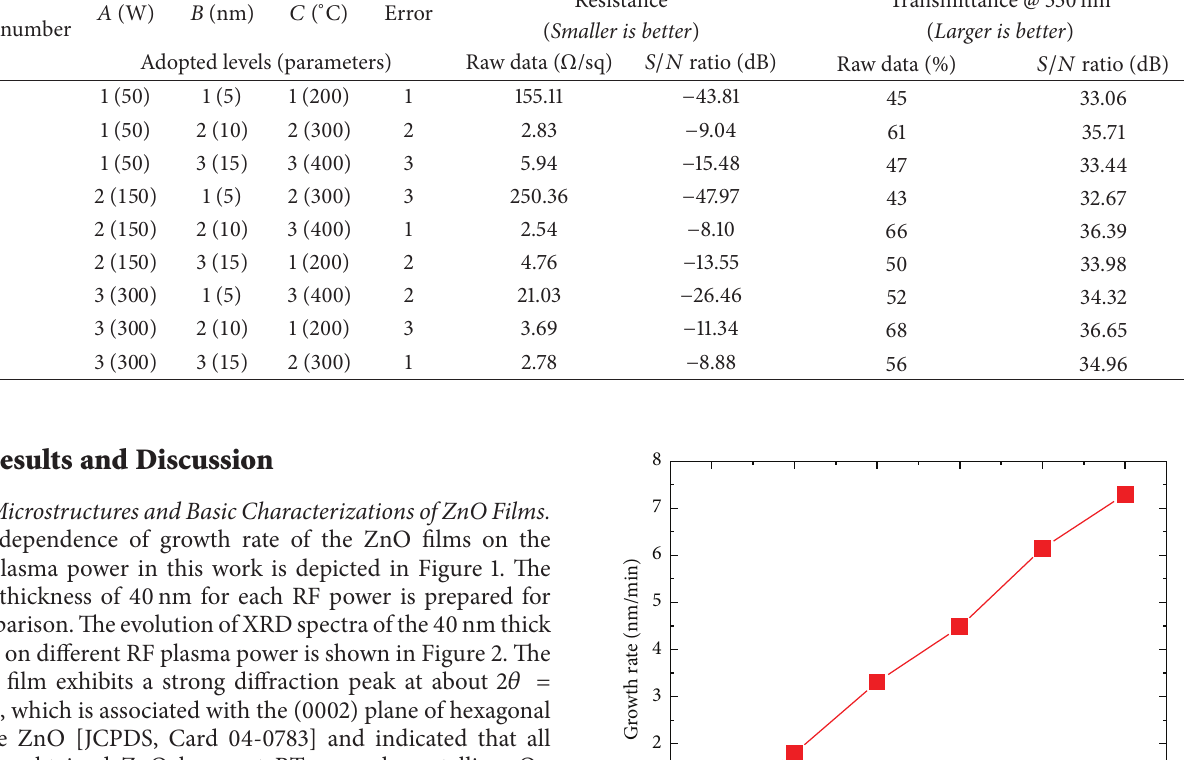
Table 2: Experimental results and 𝑆/𝑁 ratios for the resistance ( Ω /sq) and the transmittance (%) at the wavelength of 550 nm for ZAZ stacked layers (Taguchi orthogonal array table of 𝐿 9 (3 4 ) ). Exp. number